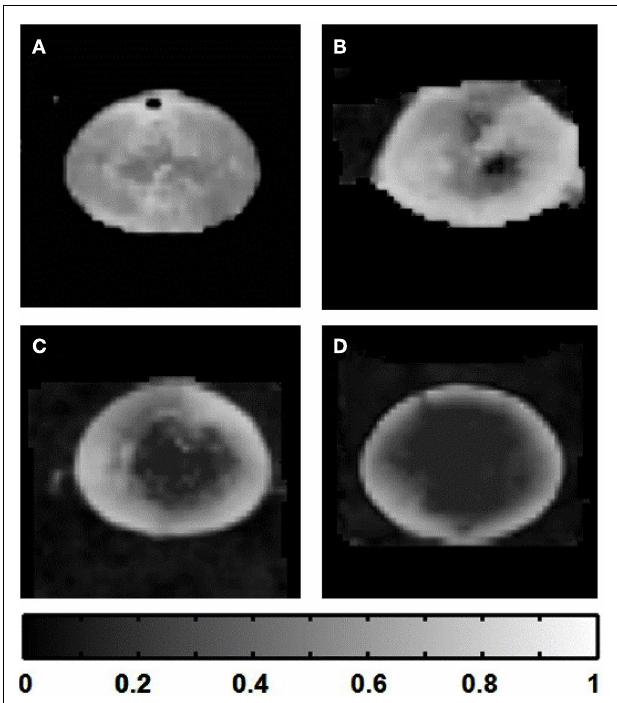
FIGURE 9 | Improvement of fractional anisotropy (FA) maps of the lens as the number of diffusion gradient directions was increased. Grayscale FA maps passing through the visual axis of the lens (see Figures 1B,C ) were calculated from eigenvalue maps ( Figure 8 ) based on lens image slices acquired using the four different scanning regimes described in Table 1 .Those regimes ranged from 6 to 30 diffusion gradient directions. (A) FA map calculated based on six diffusion gradient directions. (B) FA map based on 12 diffusion gradient directions. (C) 20 directions. (D) 30 directions.The grayscale strip at bottom indicates the FA value range in the images.